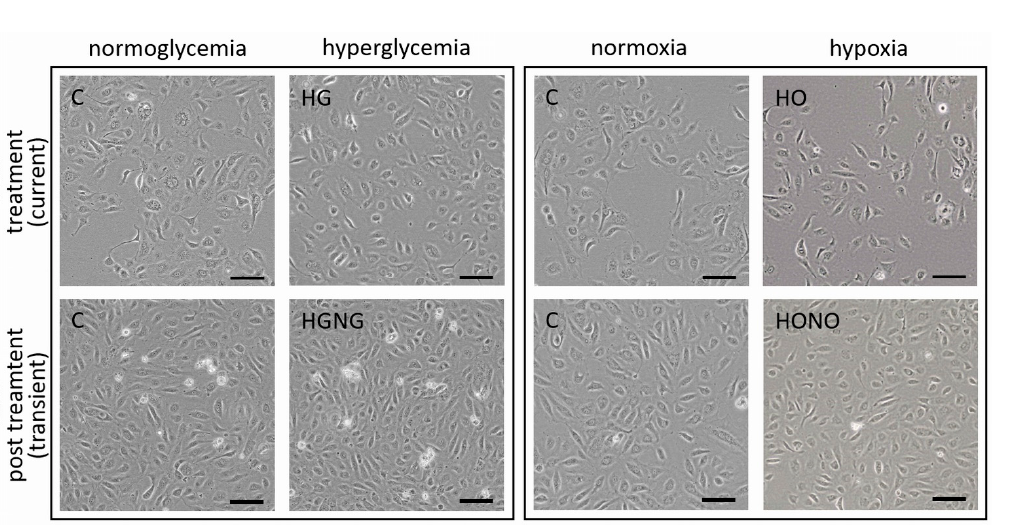
Figure 2. Microscopic morphology and growing pattern of fpEC. Representative pictures of cells cultured at current and transient hyperglycemia (HG; HGNG, left panel) and hypoxia (HO; HONO, right panel) and at control conditions. Scale bar: 100 µm.